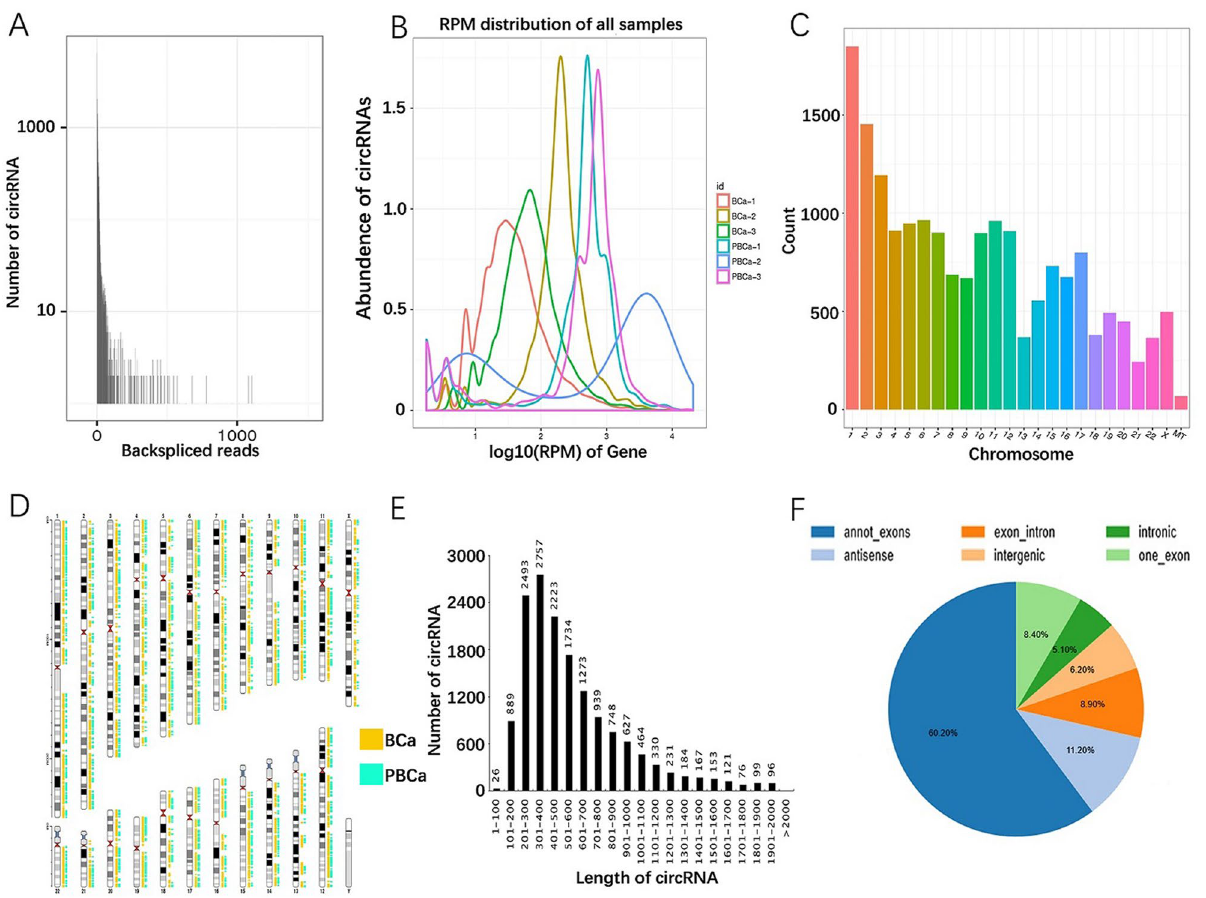
Figure 2. Statistics of identified circRNAs. ( A ) Number and backspliced reads of the circRNAs in 3 paired breast cancer tissues and matched paracancer tissues. ( B ) Horizontal axis: expression levels of circRNAs computed using RPM. Density is the number of genes on the horizontal axis divided by total number of expressed genes. ( C , D ) Number and distribution of circRNAs on each chromosome (count: number of circRNAs distributed on each chromosome). ( E ) Length distribution of circRNAs. ( F ) Type distribution of circRNAs. Compositions: Annot_exon: completely exons; Exon_intron: exons and intron; Intronic: